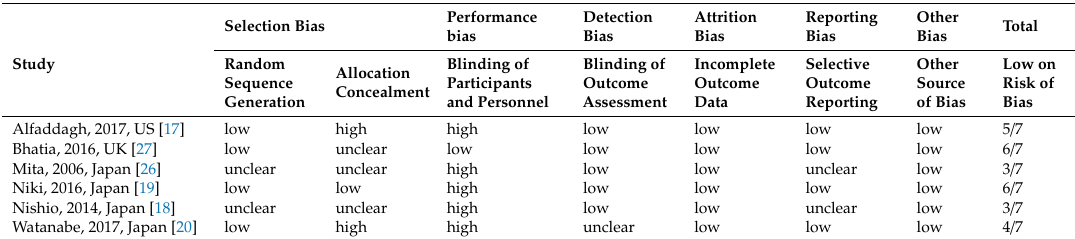
Table 3. Risk of bias for each trial.